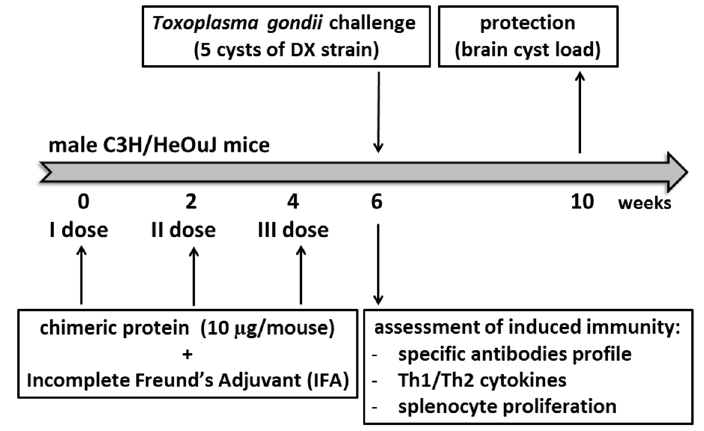
Figure 1. The experimental schedule of mouse immunization and challenge.